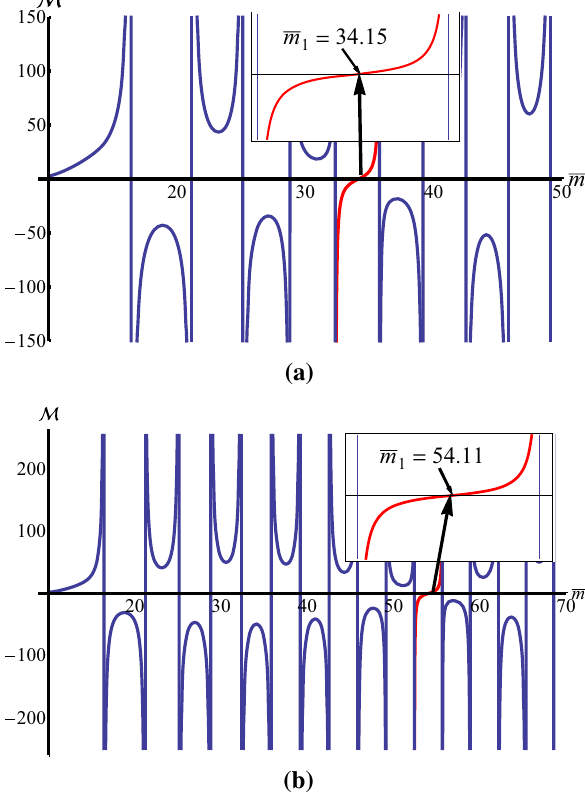
Fig. 7 The effect of the size of the extra dimension ¯ z b (small ¯ z b < 1) on the massive vector KK modes. The parameters are set to k = − 3, and τ = = − 3